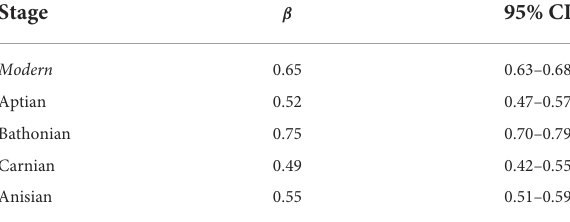
TABLE 2 Summary of posterior distributions for slopes ( β ) from the Bayesian linear regressions between ntp and mcl for Mesozoic and modern communities.